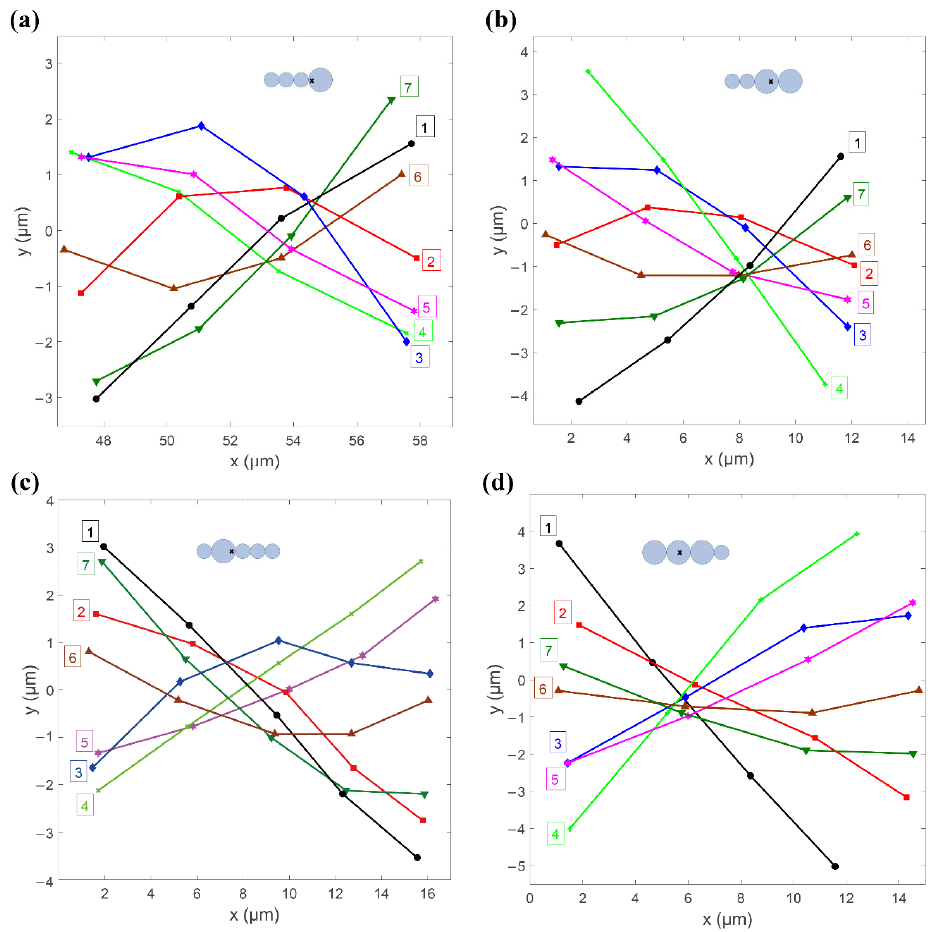
Figure 3. Waveform evolutions for the ( a ) L1S3, ( b ) L2S2, ( c ) S1L1S3, and ( d ) L3S1 swimmers shown in Figure 2. The dots mark the theoretical position of the center of mass of the swimmer, while the numbers represent the sequential waveforms of the swimmer within a full oscillating period. The interval of each waveform is 5P / 30, as shown in the sequential images in Figure